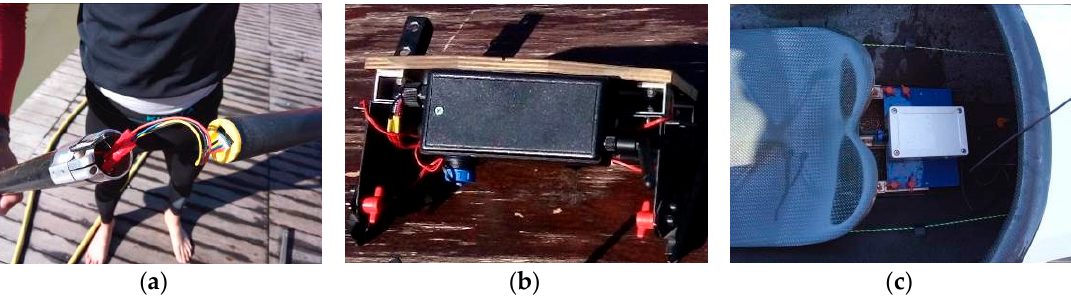
Figure 2. e-Kayak system: ( a ) paddle node, ( b ) footrest node, and ( c ) master node installed on the boat.